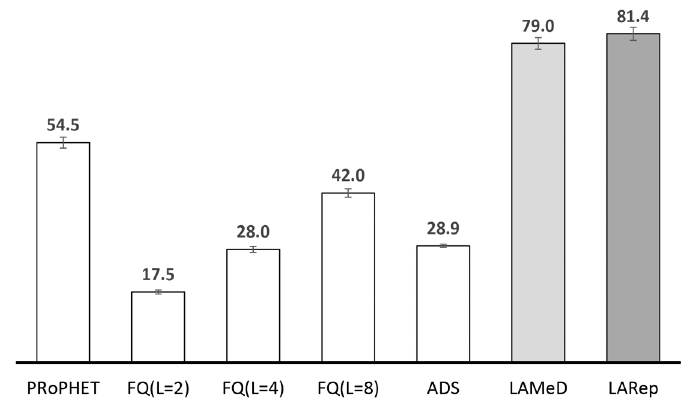
Figure 17. Throughput (in %) in the Skudai scenario.